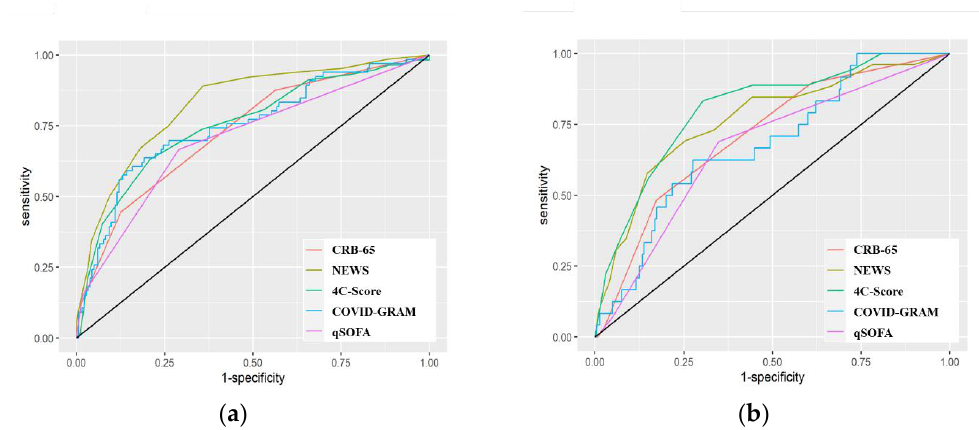
Figure 2. Plots of area under the receiver operating characteristics of the scores. ( a ) ICU admission ( b ) and in-hospital mortality. Abbreviations: CRB , confusion, respiratory rate, blood pressure; NEWS , National Early Warning Score; COVID , coronavirus disease; GRAM , Guangzhou Institute of Respiratory Health Calculator at Admission; qSOFA , quick sequential organ failure